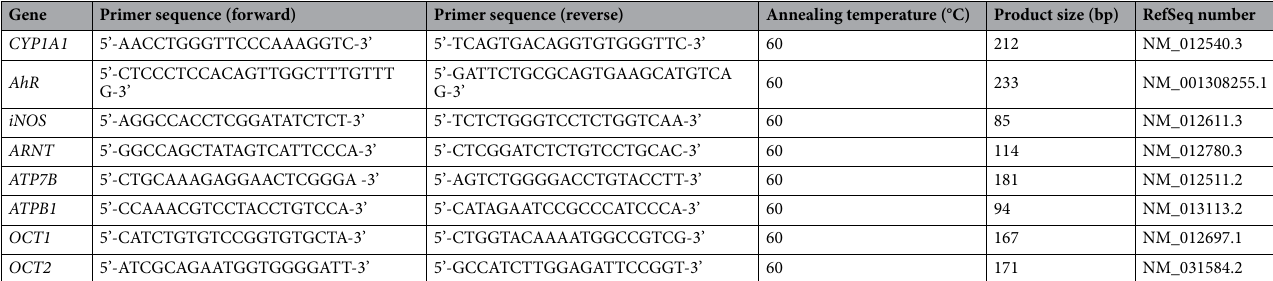
Table 2. Oligonucleotide primer sequences for quantitative reverse transcriptase polymerase chain